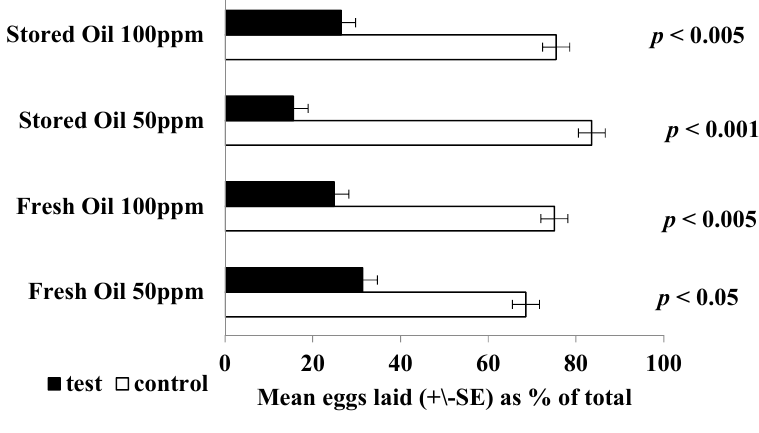
Figure 2. Oviposition responses of gravid Aedes aegypti to aqueous solutions of fresh and stored samples of essential oil from Croton rhamnifolioides . The values represent mean percentages (±SE) of the total eggs laid after 16 h in response to the treatment. Each assay involved ten mosquitoes and was replicated eight